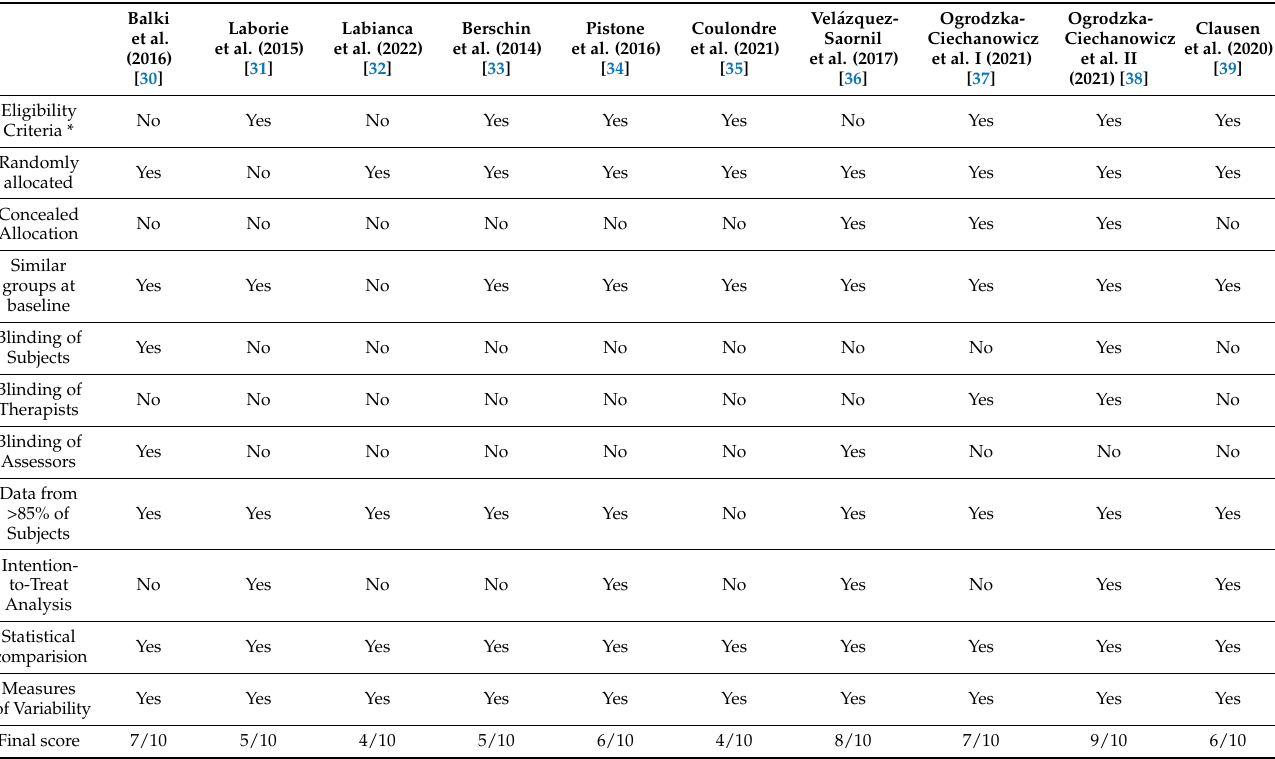
Table 4. PEDro score quality assessment.